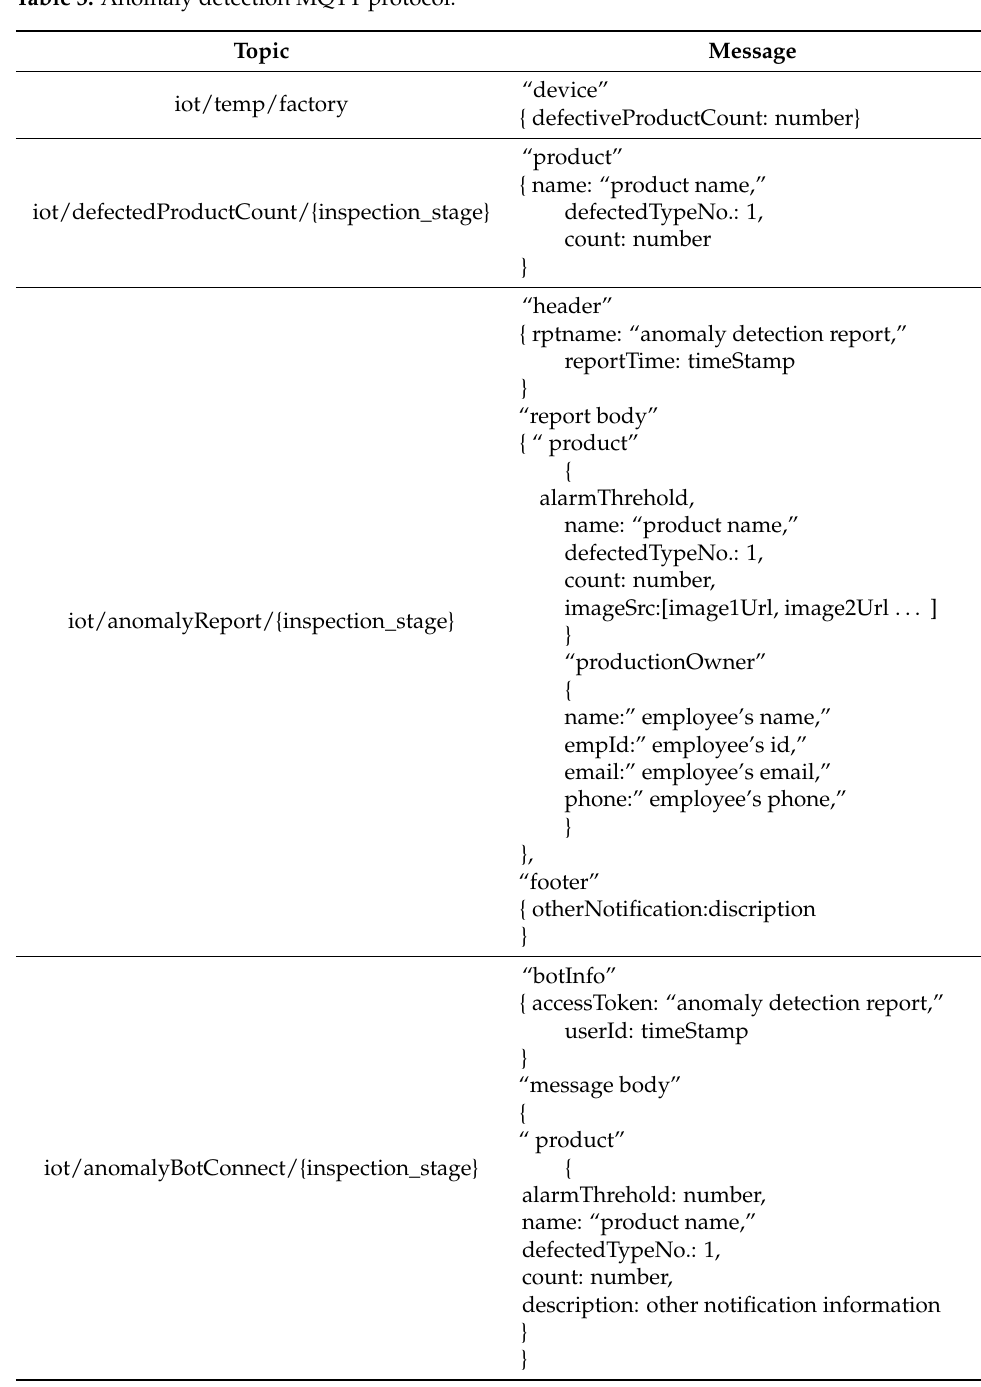
Table 3. Anomaly detection MQTT